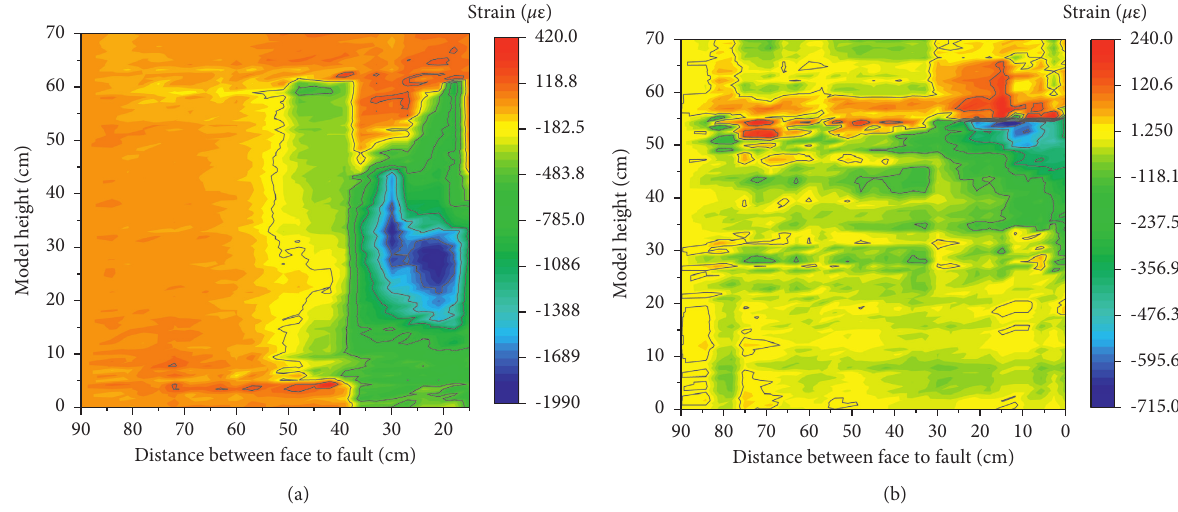
Figure 9: Variation of fault plane strain distribution during coal mining. (a) Physical Model I. (b) Physical model